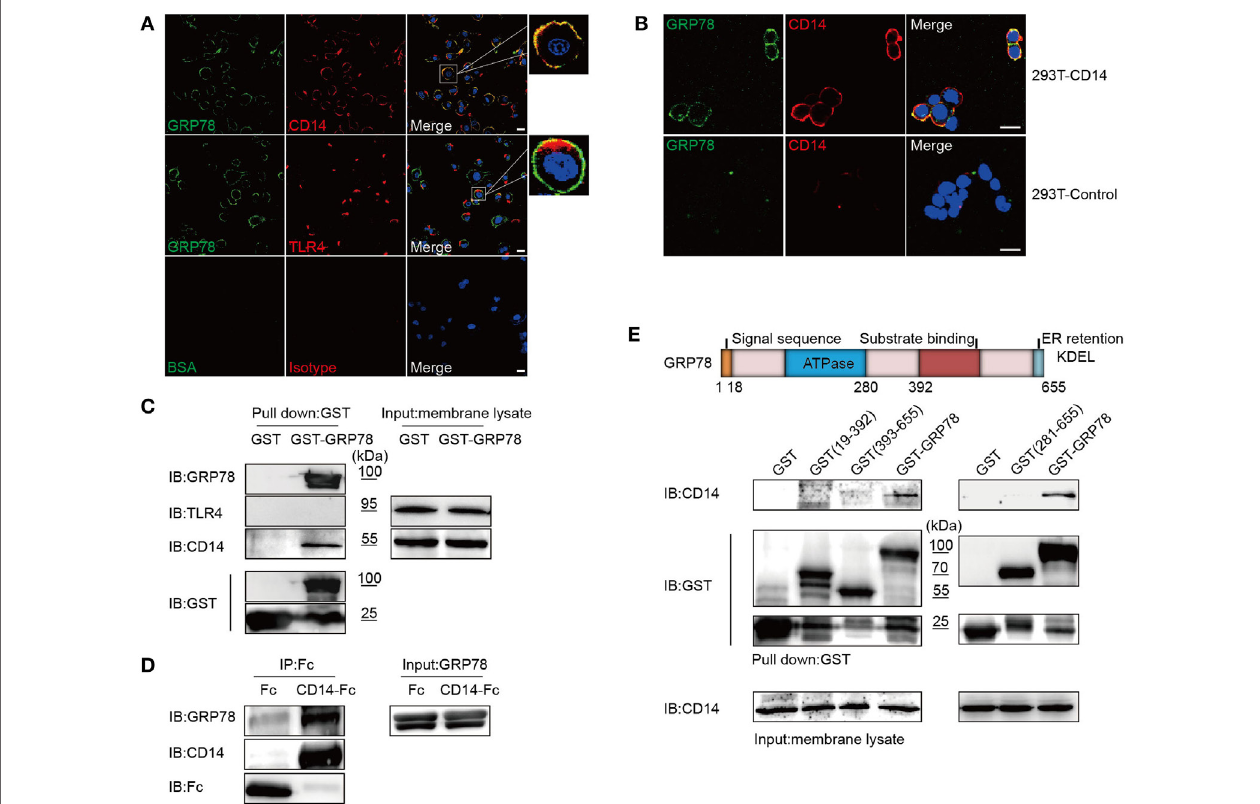
FigUre 4 | grP78 interacts with cD14 . (a) DC2.4 cells were treated with AF488-GRP78 (green) for 1 h at 4°C, and then TLR4 and CD14 (red) were stained. (B) pcDNA3.1-CD14 transiently transfected HEK293T cells were incubated with AF488-GRP78 and then CD14 was stained. Fluorescence localization was determined by confocal laser scanning microscopy. (c) Immunoblotting of the interaction of proteins with GST-GRP78, after incubation with membrane lysates of DC2.4 cells, followed by precipitation by glutathione agarose beads. (D) Protein precipitation study of CD14-Fc with GRP78. The cDNA encoding mouse CD14 was cloned into the pOptiVEC-hIgG1-Fc vector. Recombinant CD14-Fc and Fc control proteins from culture supernatants of HEK293T cells transiently transfected with plasmids were immobilized onto protein G-agarose, followed by incubation with GRP78 at 4°C overnight. The precipitates were immunoblotted using antibody specific for hIgG1-Fc, GRP78, and CD14. (e) Schematic representation of recombinant GRP78 (upper). Interaction of GRP78 fragments (amino acids in parentheses) with CD14 was assessed by GST precipitation, as described in (D) . All images for all panels are representative of at least three independent experiments in which > 100 cells were examined and > 95% of cells showed similar staining. Scale bar, 20